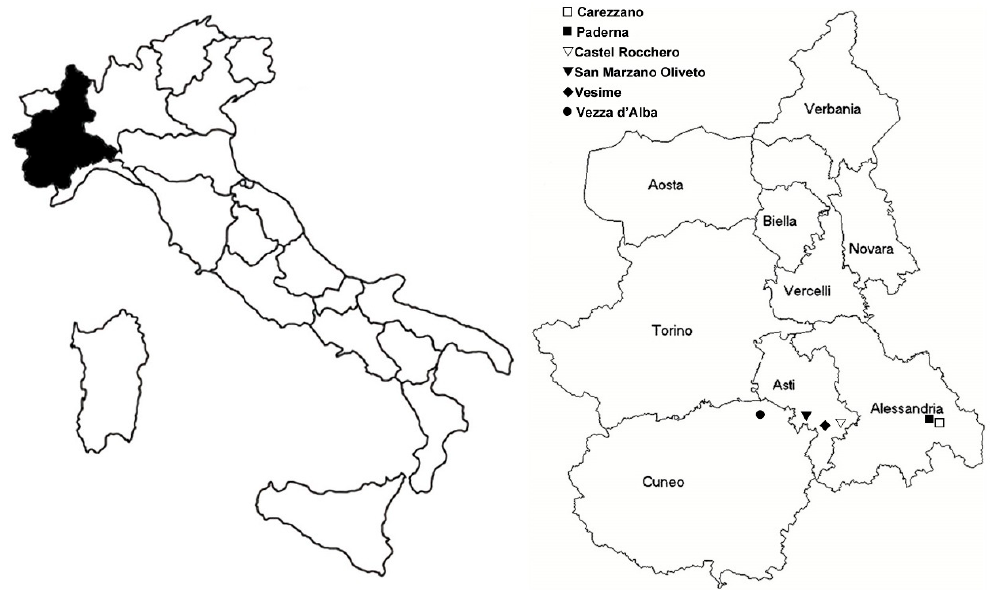
Figure 2. Piemonte Region: localization of the different vineyards under analysis for field acquisition experiments of Flavescence dorée phytoplasma by Scaphoideus titanus .